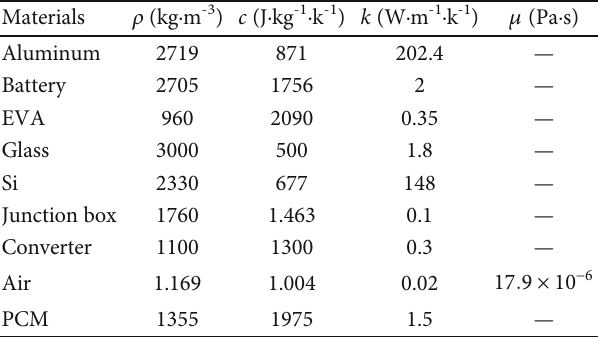
Table 1: Physical property parameters used in the